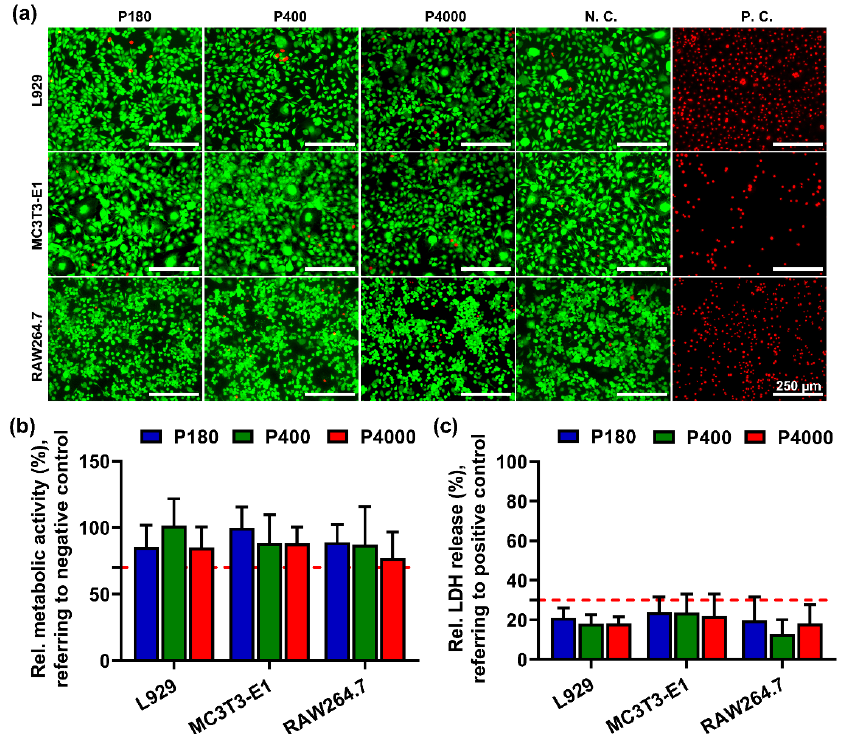
Figure 4. Cytotoxicity evaluation of specimens with different roughness surfaces. ( a ) Representative fluorescent staining images of L929, MC3T3-E1, and RAW264.7 cultured in sample extracts for 24 h (magnification 100 × , scale bar = 250 μm ). Titanium-based alloy extracts were used as a negative control (N.C.), and pure copper extracts as a positive control (P.C.). The viable cells present green fluorescence while the dead cells show red fluorescence. ( b ) Relative cell metabolic activity of L929, MC3T3-E1, and RAW264.7 after culturing in sample extracts for 24 h detected by CCK-8 assay. Red line indicates 70% of negative control. ( c ) Relative LDH release of three types of cells for 24 h. Maximum cell LDH release was used as a positive control and set to 100%. Dashed line indicates 30% of control, suggesting a line of cytotoxicity effect.